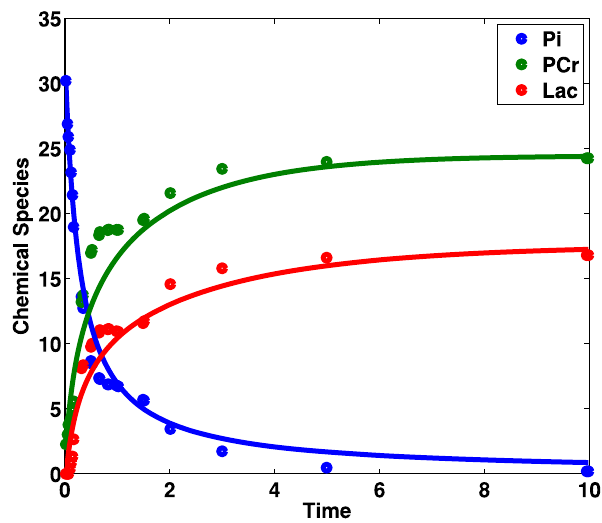
Figure 4. Input and Output time course data for chemical species of the muscle glycolytic pathway. The pathway describes interactions between phosphate (Pi), phosphocreatine (PCr) and lactate. Open circles represent the input time course data. Solid lines represent the output time course data. We produced the output using the Empirical information criteria. The predicted time course data provides a good qualitative fit to the experimental data. MIKANA also reconstructs the interaction relationships between Pi, PCr and lactate in the muscle cell pathway.